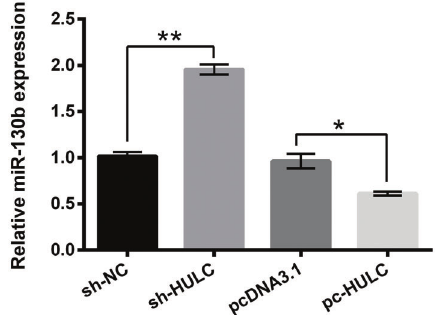
Figure 3. Highly up-regulated in liver cancer (HULC) negatively regulated the expression of miR-130b in GH3 cells. After sh- HULC or pc-HULC transfection, the expression level of miR-130b in GH3 cells was detected using qRT-PCR. miR-130b: MicroRNA- 130b; NC: negative control. Data are reported as means ± SD. *P o 0.05; **P o 0.01